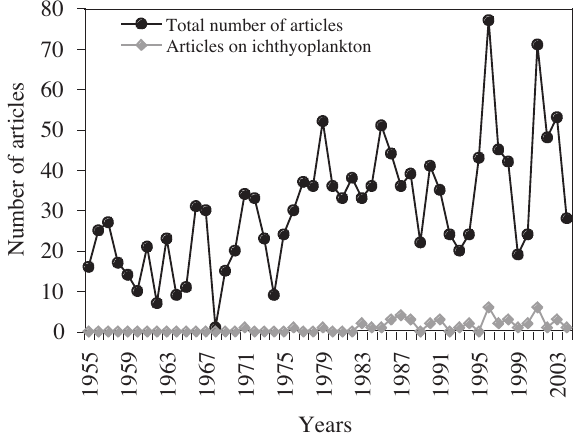
papers published by these